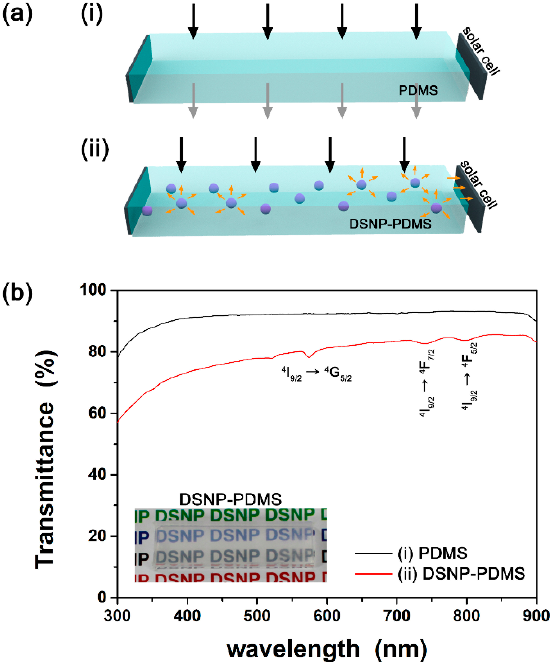
Figure 6. ( a ) Schematic illustration of ( i ) bare PDMS- and ( ii ) DSNP-PDMS composite-coupled solar cells. ( b ) Transmittance spectra of ( i ) the bare PDMS polymer and ( ii ) the C/S/S DSNP-PDMS composite. Inset shows a photograph of the C/S/S DSNP-PDMS composite.